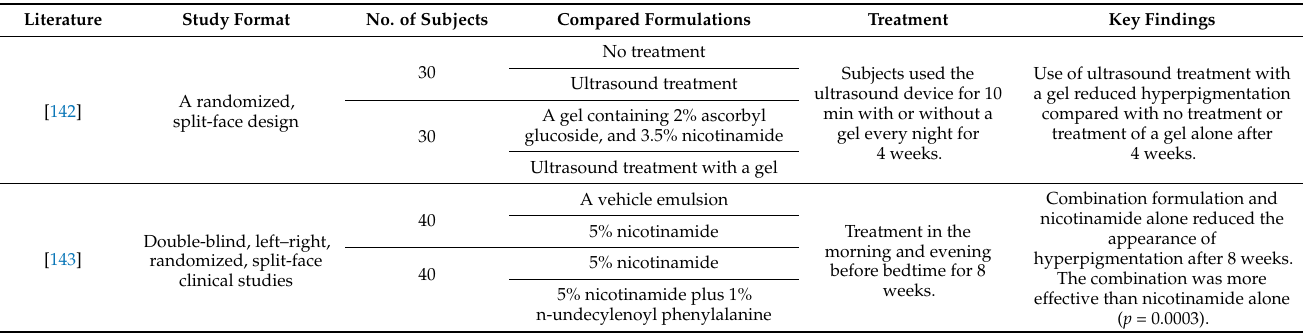
Table 3. Skin-lightening efficacy of cosmeceuticals containing nicotinamide in combination with other active ingredients.